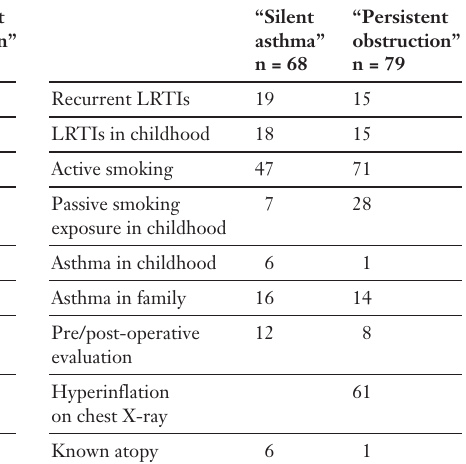
Table 3 Alternative indication for performing PFTs in UDAO screening.